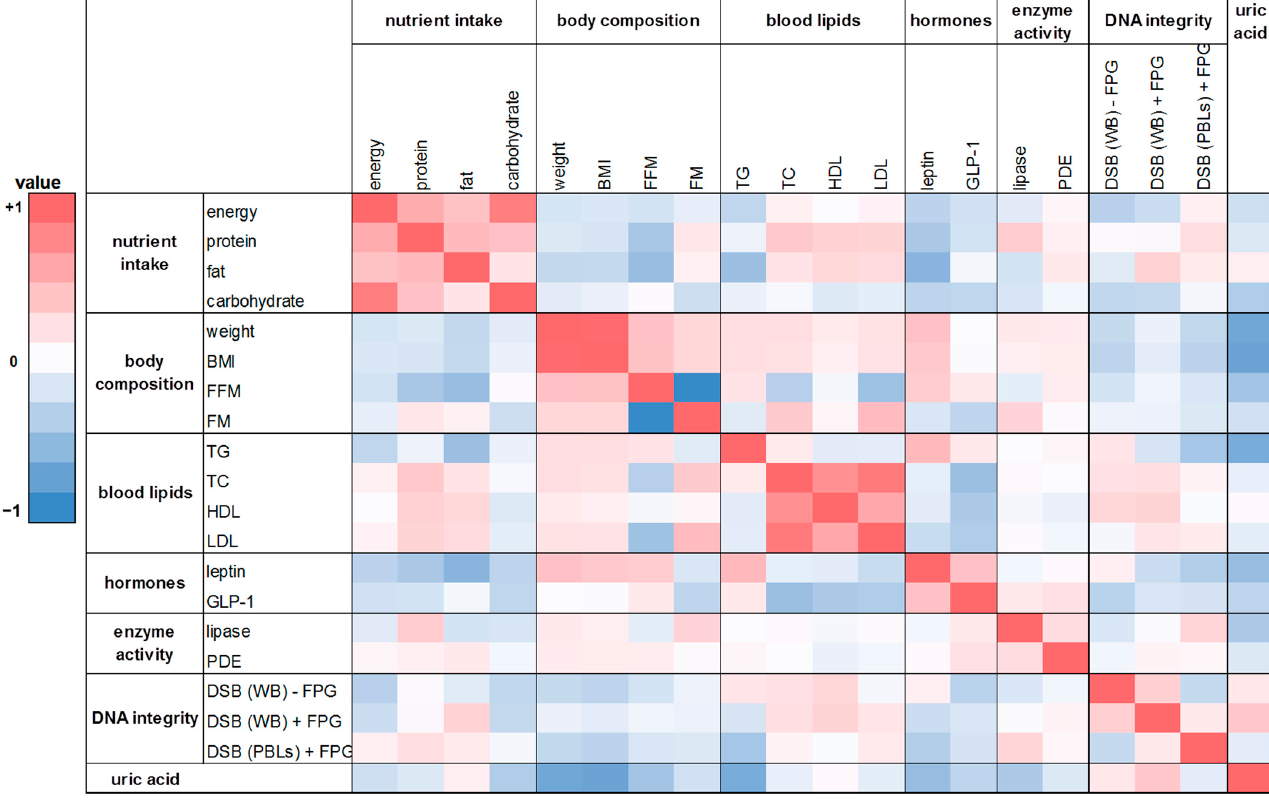
Figure 7. The heat map correlation matrix of all parameters investigated during the human intervention study. The coefficients were calculated based on the changes between the washout period and the intervention period after eight weeks. Colored fields: red: positive correlation; blue: negative correlation.